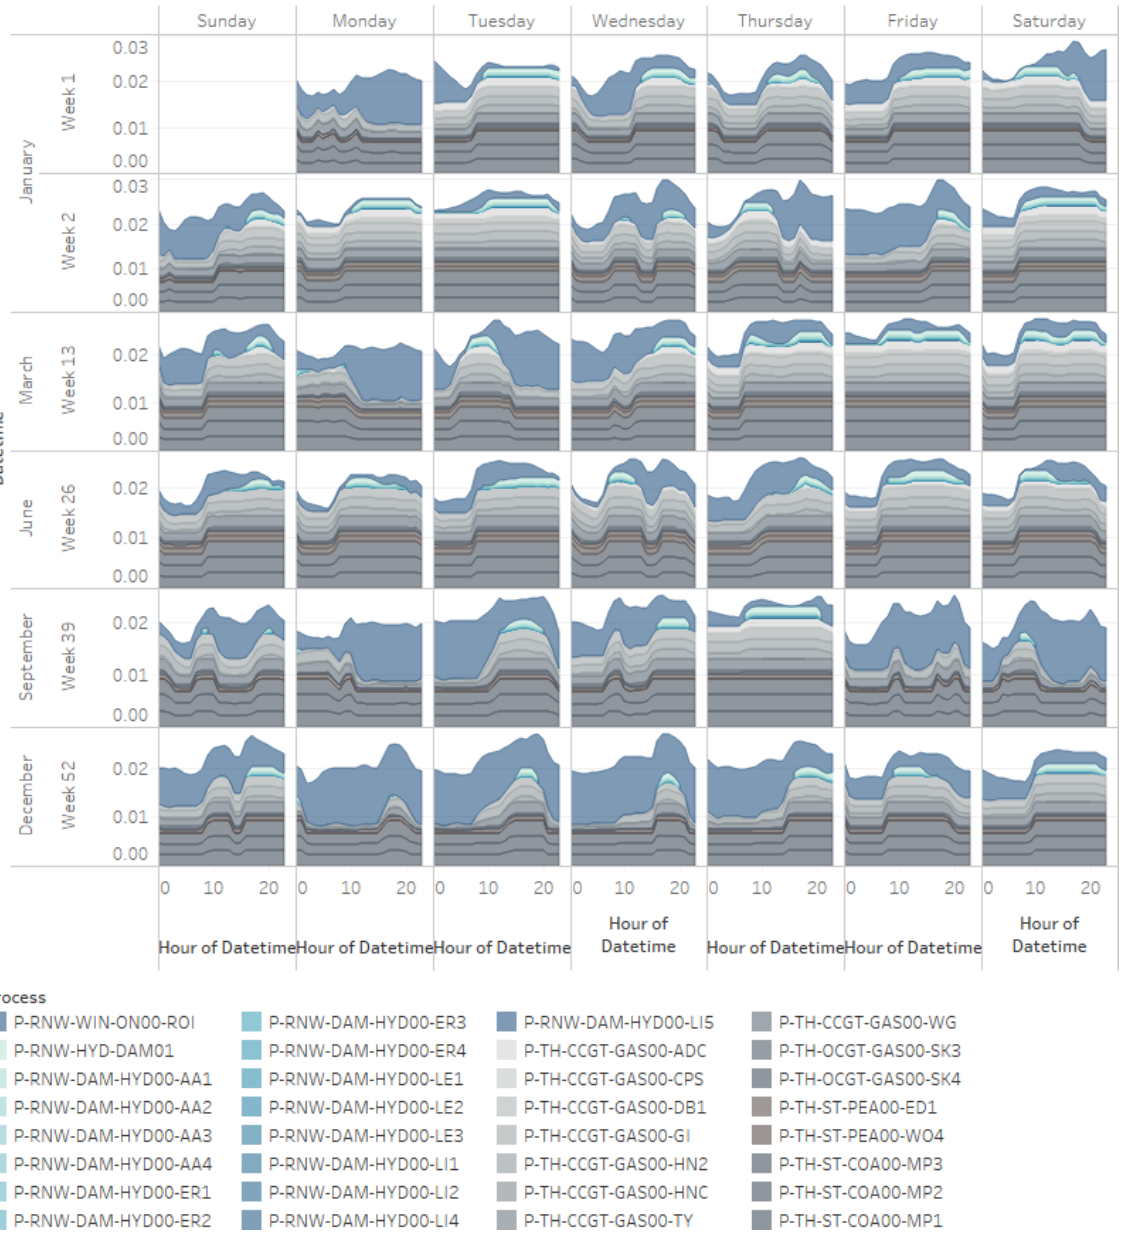
Figure 2. TIM hourly unit commitment modelling capabilities example for